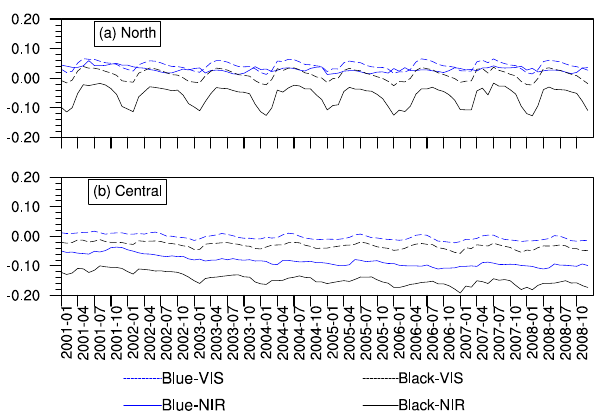
Figure 7. Monthly time series of difference between PSALB and MODIS (PSALB-MODIS) spatially averaged over the northern and central boxes shown in the black-sky NIR yearly panel in Fig. 6.